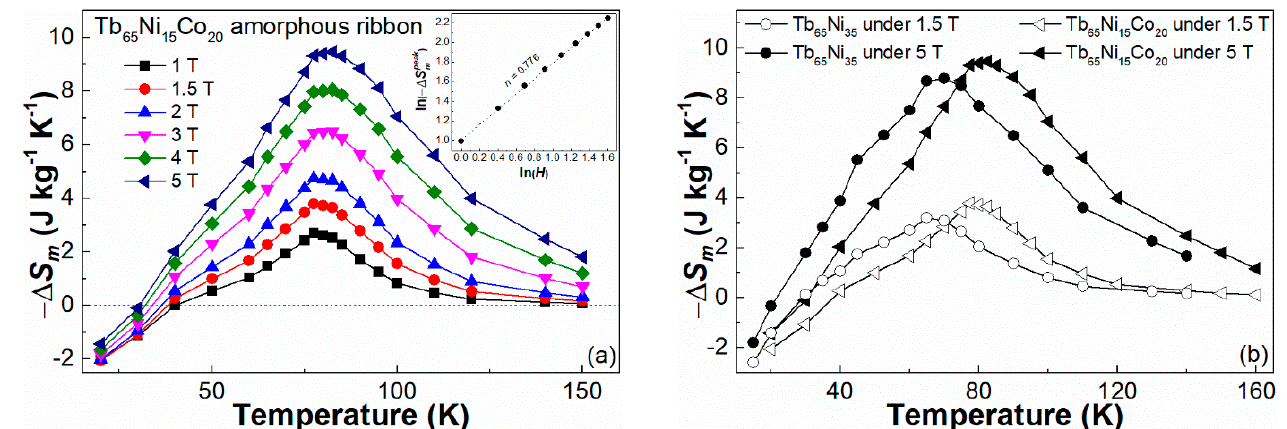
Figure 5. ( a ) The − ∆ S m - T curves of the Tb 65 Ni 15 Co 20 amorphous ribbon under different magnetic fields, the inset is the linear fitting of the ln( − ∆ S mpeak ) vs. ln( H ) plots; ( b ) the − ∆ S m - T curves of the Tb 65 Ni 35 and Tb 65 Ni 15 Co 20 amorphous ribbons under 1.5 T and 5 T.